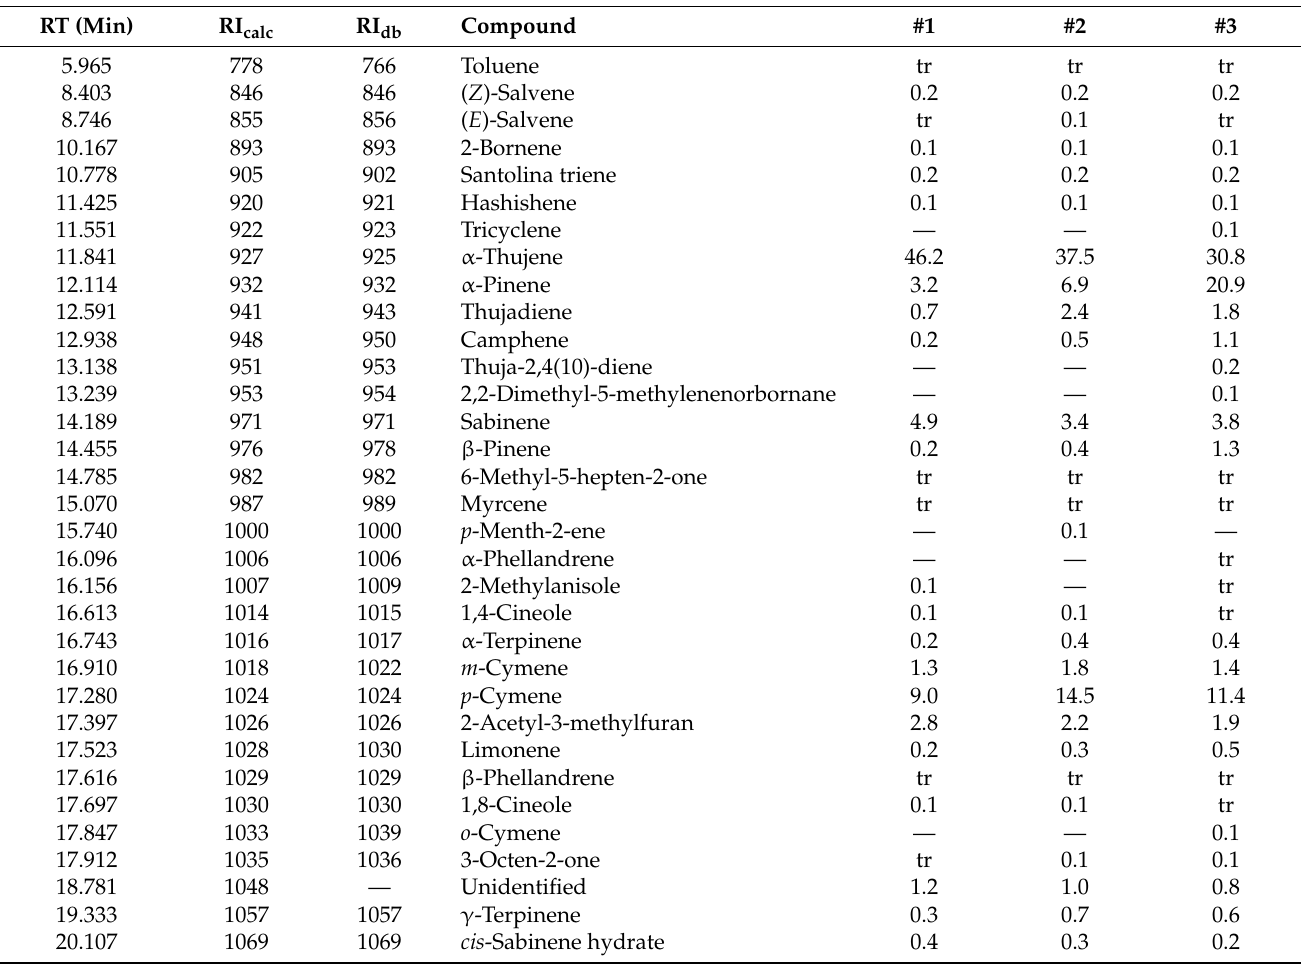
Table 1. Chemical composition (%) of Boswellia ogadensis resin essential